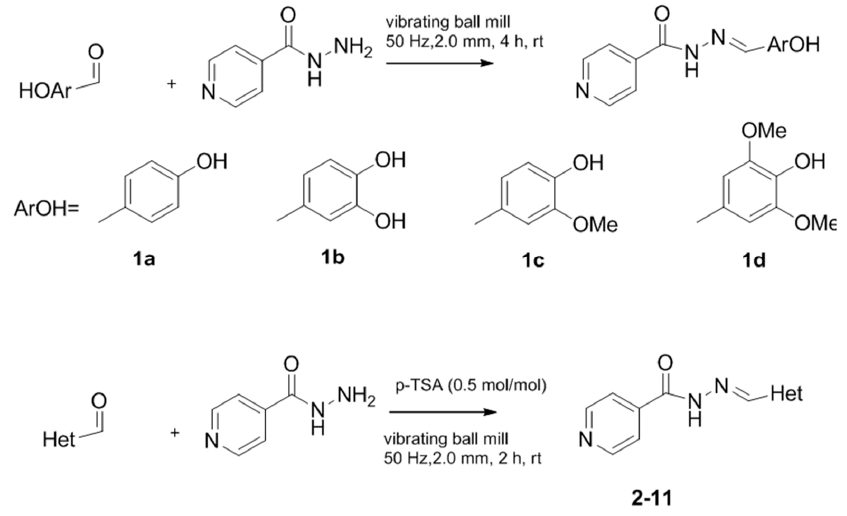
Figure 2. Isonicotinoyl hydrazones synthesized by co-grinding of isoniazide and an